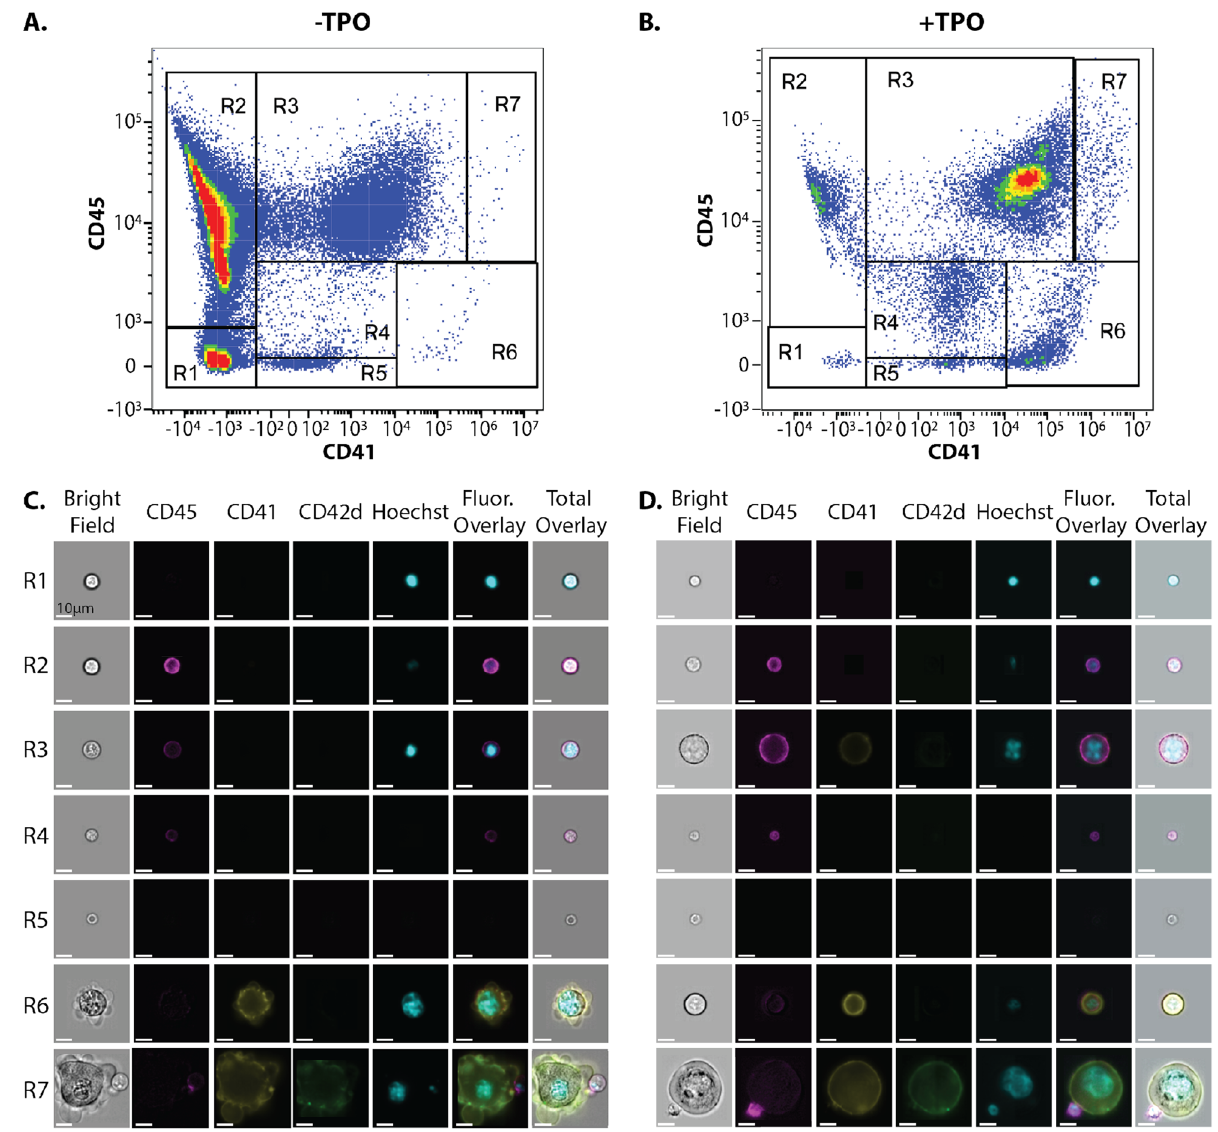
Figure 5. Classification of MK lineage subpopulations. ( A,B ) Flow cytometry plots displaying CD45 and CD41 intensity of bone marrow cells stained with MK antibodies in the ( A ) − TPO and ( B ) + TPO conditions. Seven distinct subpopulations were identified (R1–R7). ( C ) Representative images of cells in the − TPO and ( D ) + TPO conditions. Scale bars, 10 μm for all